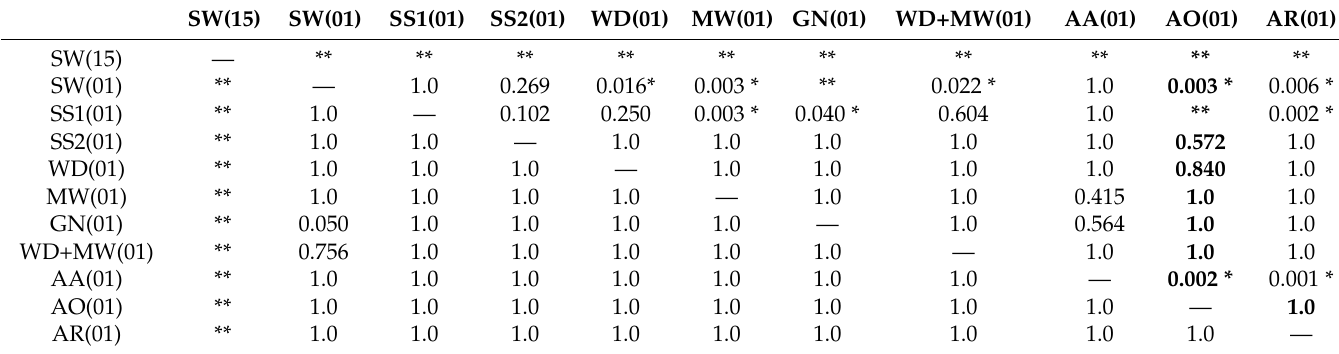
Table A11. Pairwise comparisons with Bonferonni correction for the putEMG dataset. The table shows the p -value of the comparison between the classification accuracy of the methods on the corresponding row and column. Values above the diagonal show the comparisons for R = 15 and below the diagonal for R = 1 (last and first row of Table A7, respectively). Values in bold correspond to the comparisons of the method with the highest classification accuracy in Table A7 (i.e., AO). An ‘*’ denotes a significant difference ( α = 0.05), while a ‘**’ denotes a p -value p <